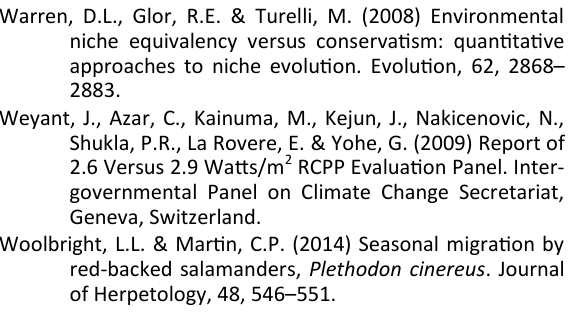
Figure S5 Map of estimated snowfall in North